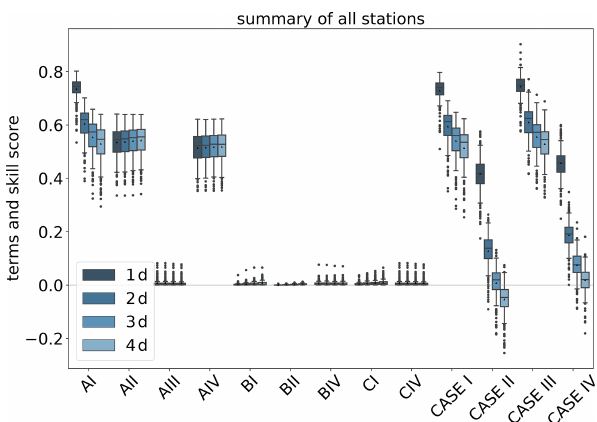
Figure A1. Skill scores of IntelliO3-ts with respect to climatologi- cal reference forecast, with internal single value reference (Case I), internal multi-value (monthly) reference (Case II), external single (Case III), and external multi-value (monthly) reference (Case IV) for all lead times from 1d (dark blue) to 4d (light blue). All terms are described in Sect. A3. Triangles denote the arithmetic